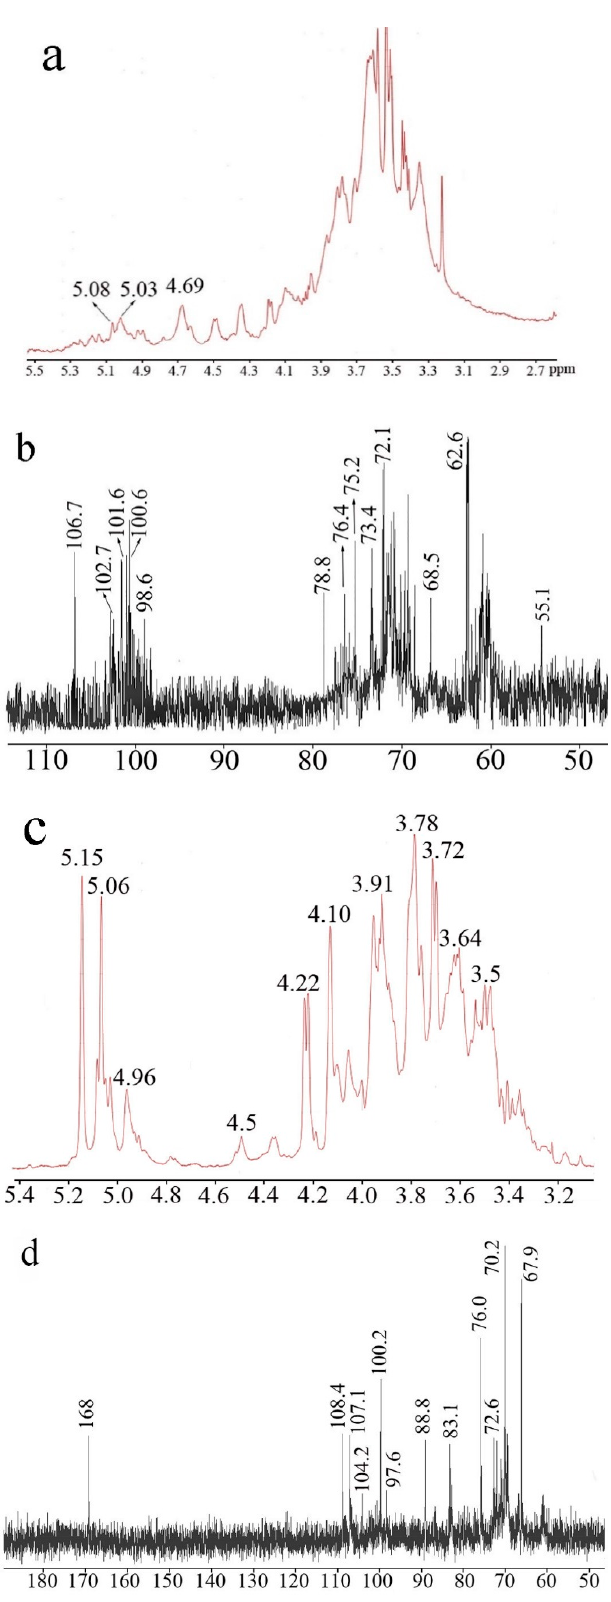
Figure 3. NMR spectra of EP0-1 and EP0.5-1 Spectra were performed at 25 °C on a Bruker 800-MHz NMR spectrometer using acetone as internal standard. ( a ) 1 H NMR spectrum of EP0-1 ( b ) 13 C NMR spectrum of EP0-1( c ) 1 H NMR spectrum of EP0.5-1 ( d ) 13 C NMR spectrum of EP0.5-1.